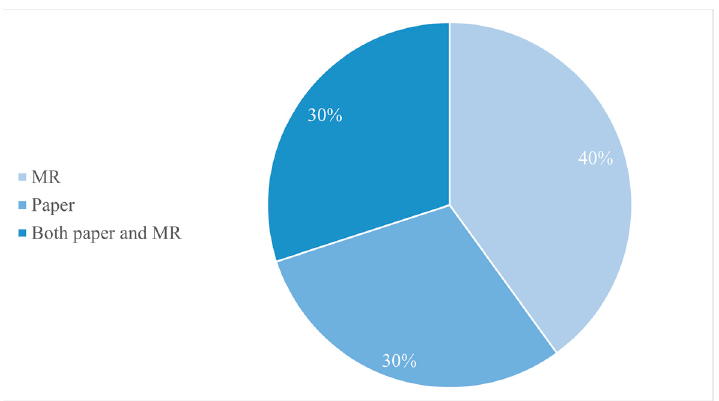
Figure 18. Answers to the questions “Did you feel more confident that you had done the assembly correctly using the MR instructions or the paper instructions?”.